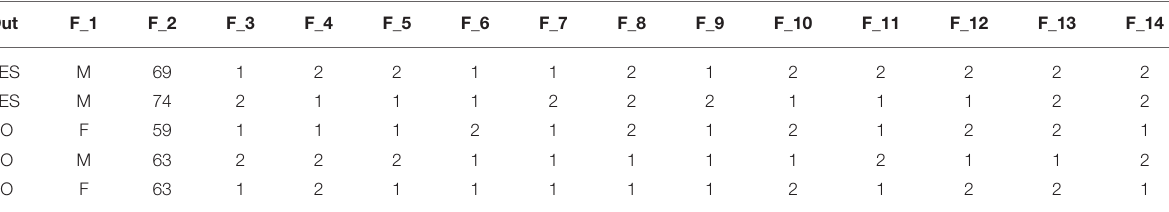
TABLE 2 | Lung cancer dataset sample.